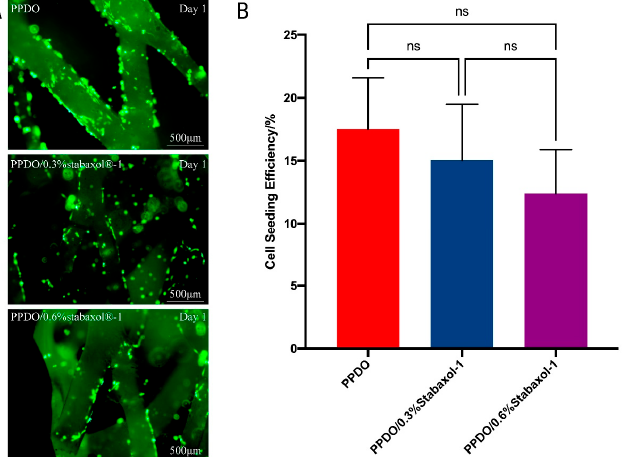
Figure 6. Adhesion of HUVECs to the different BRS groups. ( A ) Inverted fluorescence images of PPDO, PPDO/0.3% stabaxol ® -1, and PPDO/0.6% stabaxol ® -1 BRSs on day 1. ( B ) Cell seeding efficiency of HUVECs cultured on the bilayer scaffolds with different weight of stabaxol ® -1.